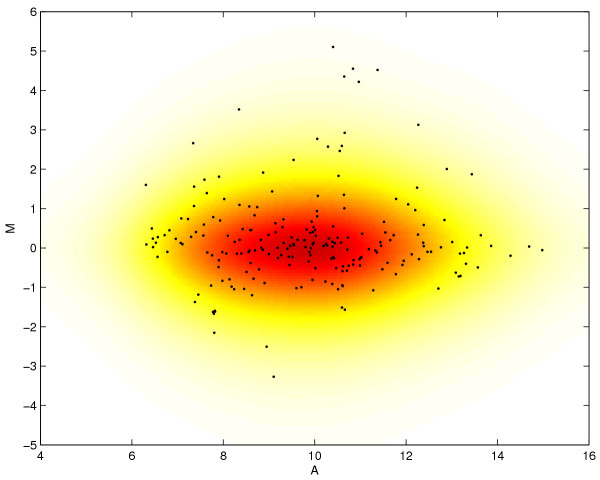
Optimized calibration results for BT-474_01 data This scatterplot shows LOWESS calibration after optimized choices of fk have been obtained for all print-tips. Compared to the results in Figure 4, the normalized data here has less overall variance. In addition, genes that have been verified experimentally conform in better agreement with the well-known biology.